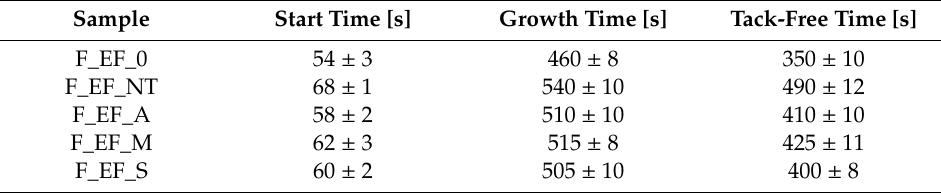
Table 2. Characteristic processing times of polyurethane foams modified with eucalyptus fibers.